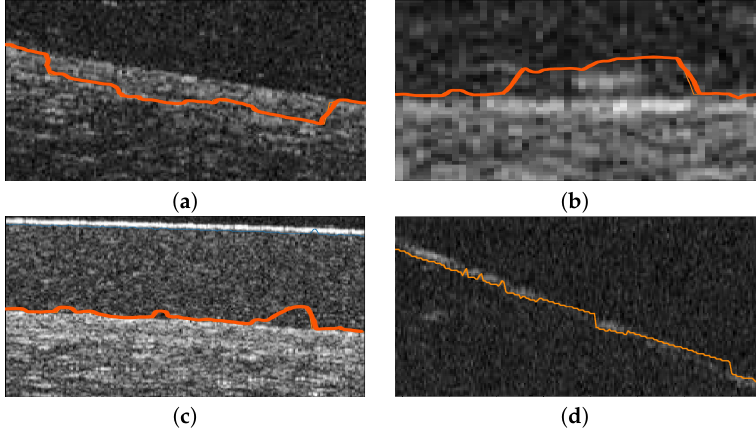
Figure 8. Example of results of the preliminary localization stage prior to the precise segmentation in different AS-OCT images ( a – d